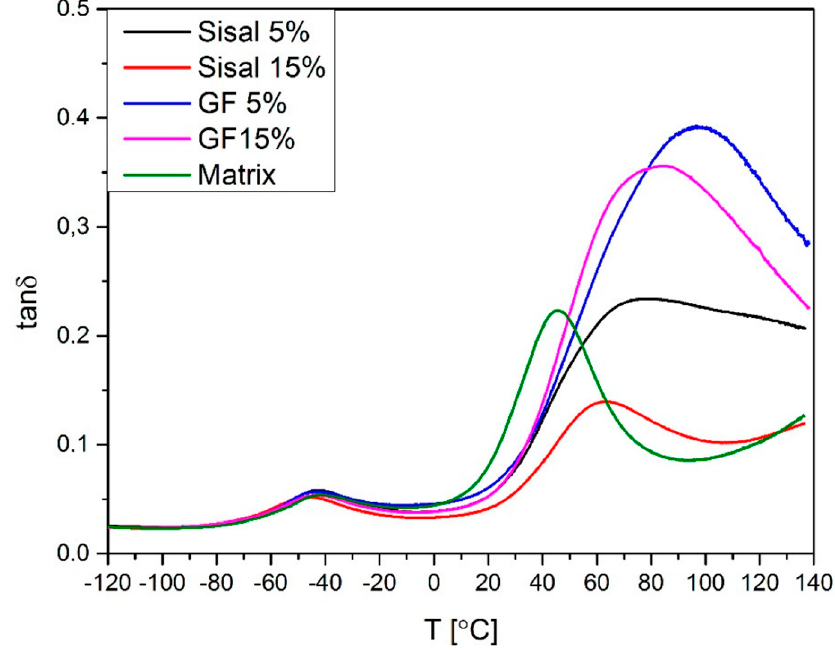
Figure 12. Loss factor (Tan δ ) values of obtained composites.